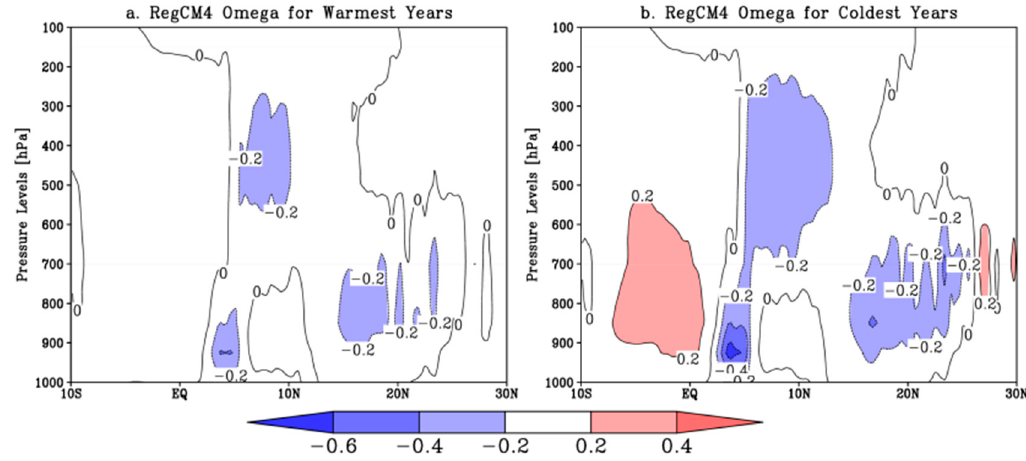
Figure 9. Averaged June to September (JJAS) of the vertical velocity over the Sahel for the warmest years and the coldest years from RegCM4.